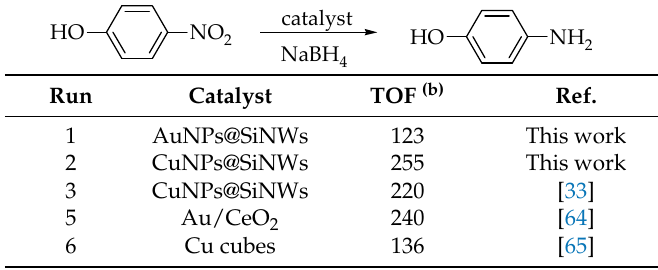
Table 4. Comparison of catalyst performance in the reduction of p-nitrophenol (a) .